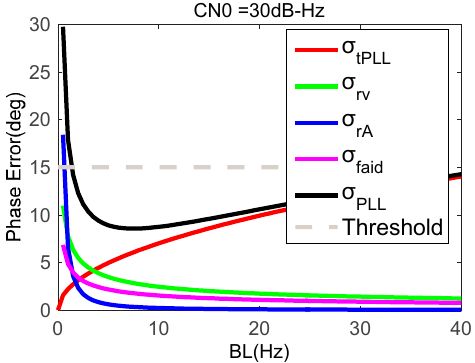
Figure 8. Phase errors of MEMS accelerometer-aided PLL with a CN0 of 30 dB-Hz.